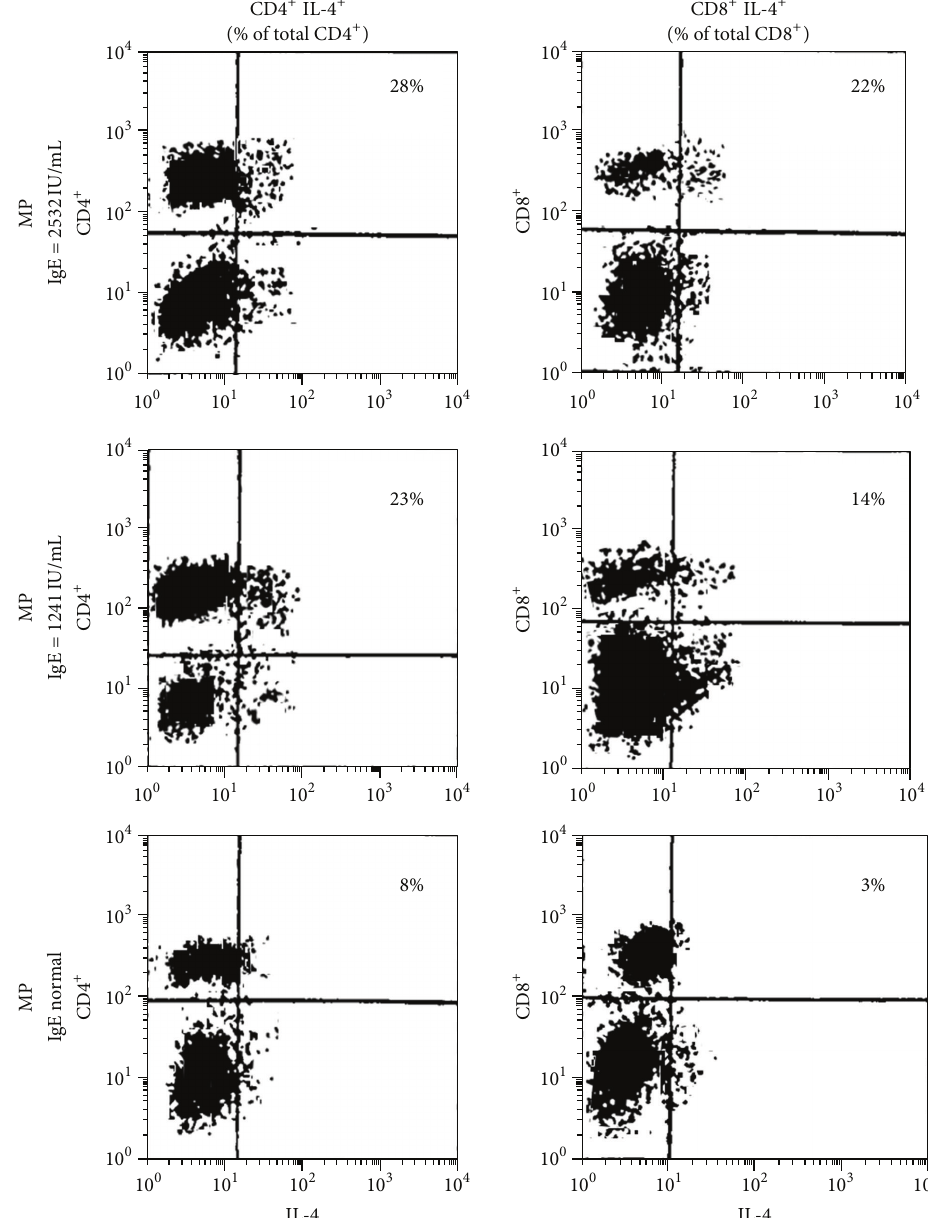
Figure 5: Representative FACS analysis of intracellular IL-4 and either CD4 or CD8 cell surface marker expression in peripheral blood lymphocytes from patients with normal or elevated IgE levels. FACS analysis is shown for a patient with normal IgE levels, a patient with moderately elevated IgE levels (1241IU/mL), and a patient with severely elevated IgE levels (2532 IU/mL). Results shown are representative of 𝑛 = 40 MPP patients with elevated IgE and 𝑛 = 20 MPP patients with normal level IgE. The proportion of cells secreting IL-4 is indicated for the CD4+ and CD8+ cells of each